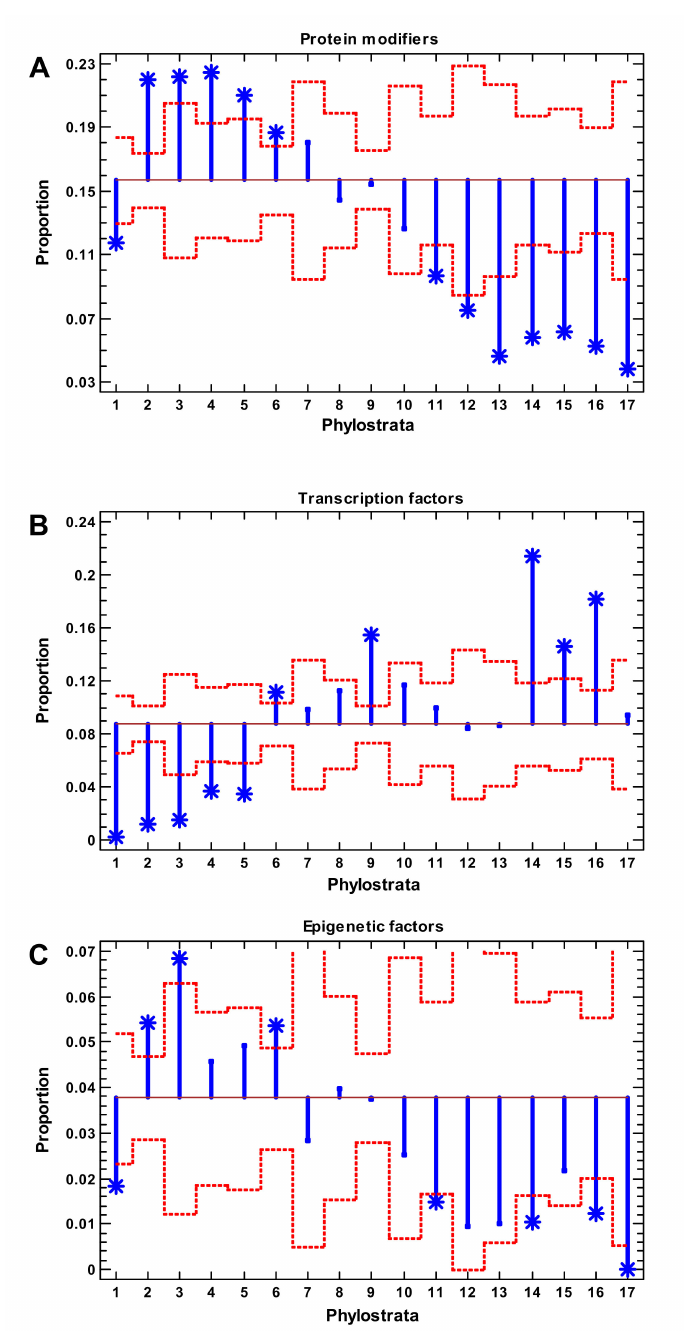
Figure 1. Gene proportion analysis of protein modifiers ( A ), transcription factors ( B ), and epige- netic factors ( C ). Red dotted lines show significance level ( p < 0.05), asterisks show significant enrichment (if above baseline) or underrepresentation (below baseline). (1—cellular organisms; 2— Eukaryota; 3—Opisthokonta; 4—Metazoa; 5—Eumetazoa; 6—Bilateria; 7—Chordata;